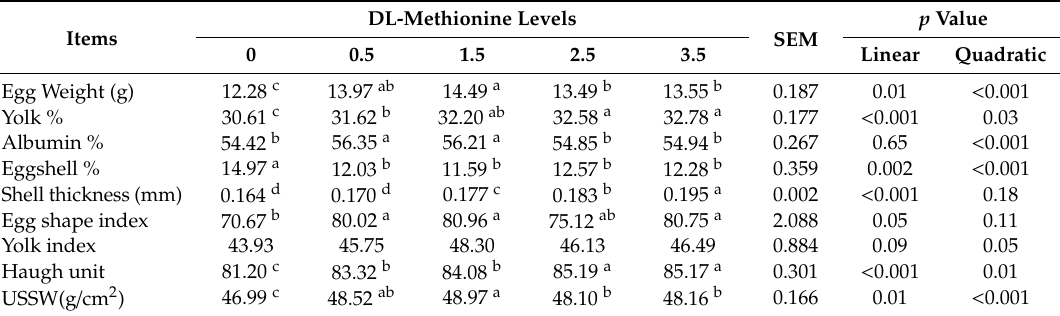
Table 4. Egg quality of Japanese quail as a ff ected by dietary